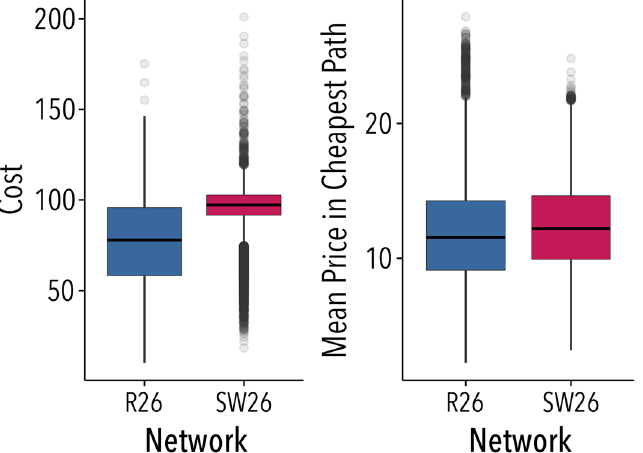
Figure 4. Numerical results of the model executed over the networks, source and destination from the experiments. Results shown are for 100 executions with 15 rounds for each network and source-destination pair, excluding the first round. Initial prices are bootstrapped from the experimental values. Values of σ and ρ are fixed and correspond to mean values of the experiment, respectively, 2.60 and 1.2. Figure created using ggplot2 (v.3.2.1) 21 .